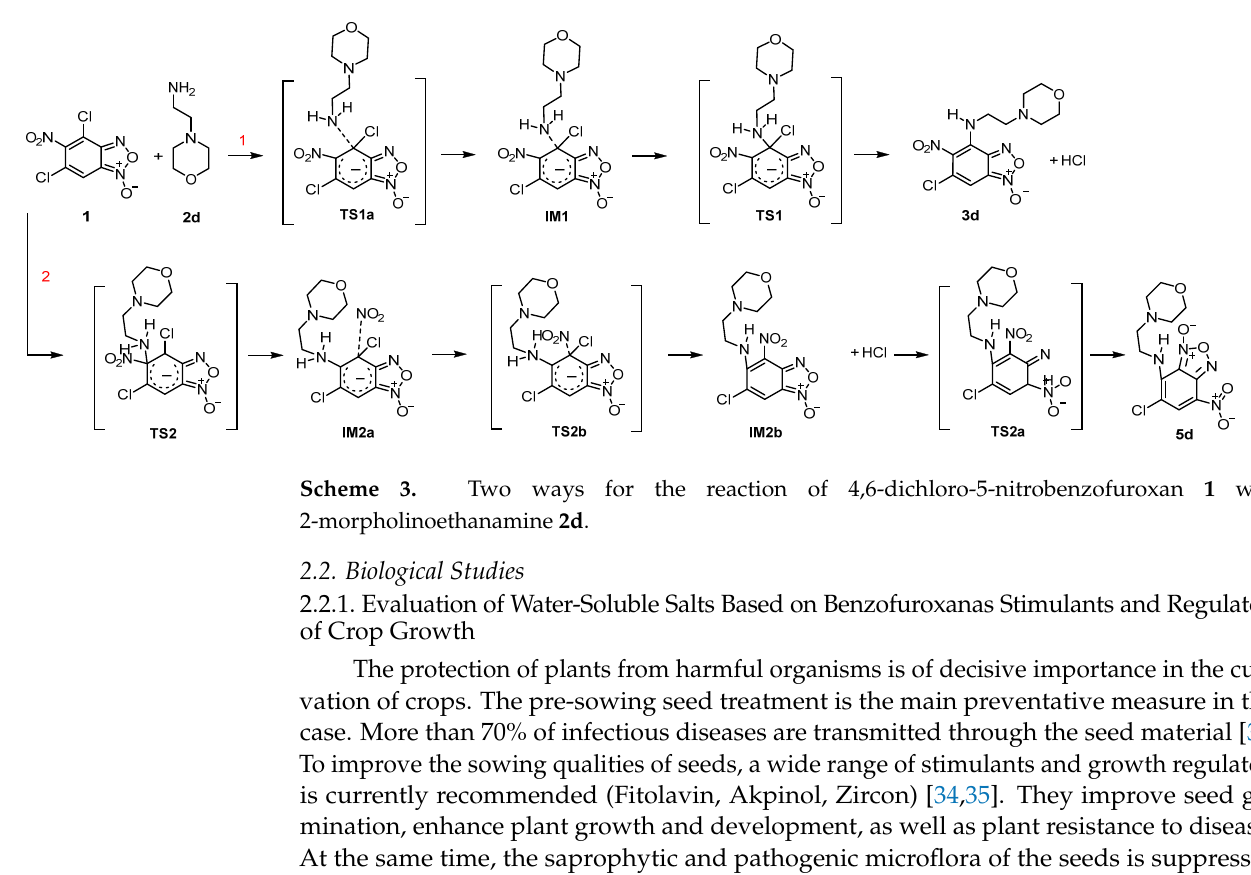
Figure 3. Energy diagram ( ∆ E, kcal/mol) of the reaction of 4,6-dichloro-5-nitrobenzofuroxan 1 with 2-morpholinoethanamine 2d .